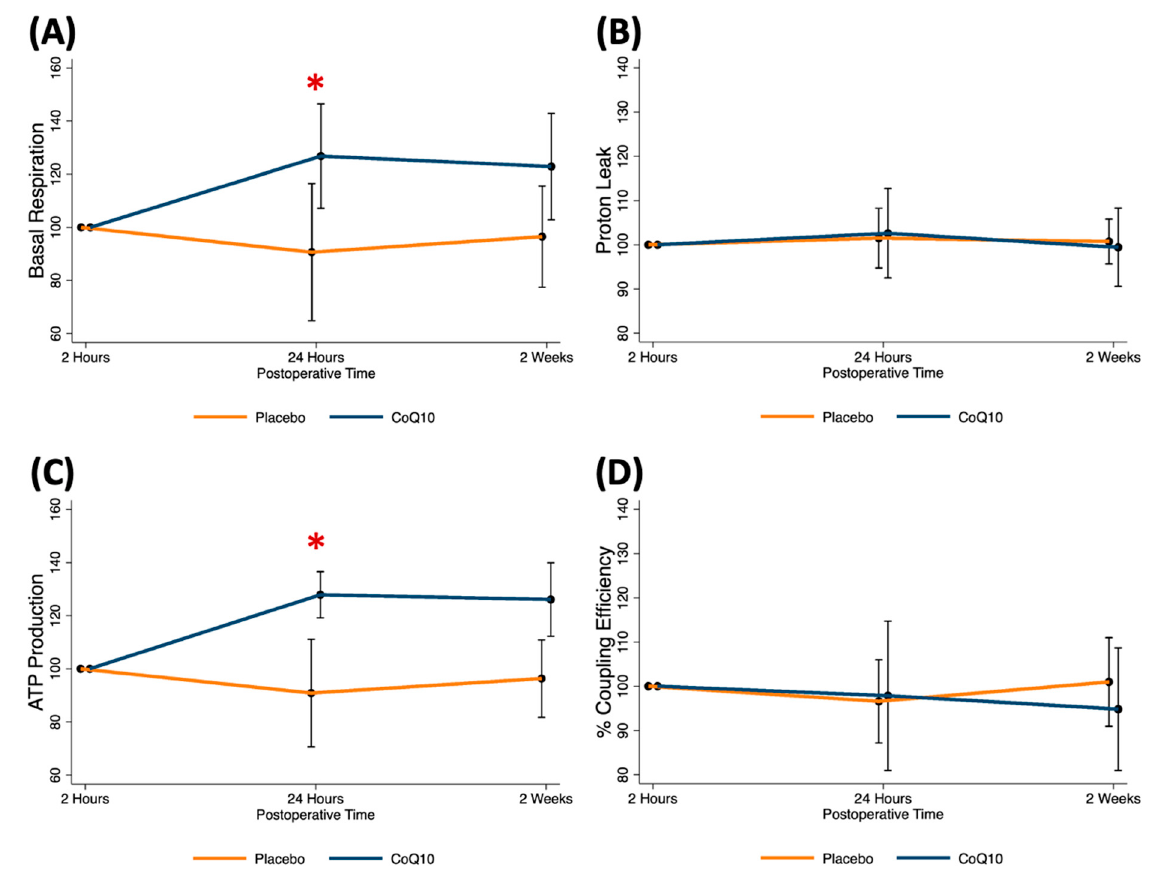
Figure 6. Mitochondrial respiration alteration following late phase of tourniquet-induced ischemia and reperfusion in patients receiving perioperative CoQ10 supplementation. ( A ) basal respiration, ( B ) proton leak, ( C ) ATP production, ( D ) % coupling efficiency. Results are presented as differences from 2-h postoperative data. * p < 0.05 between CoQ10 and placebo groups.